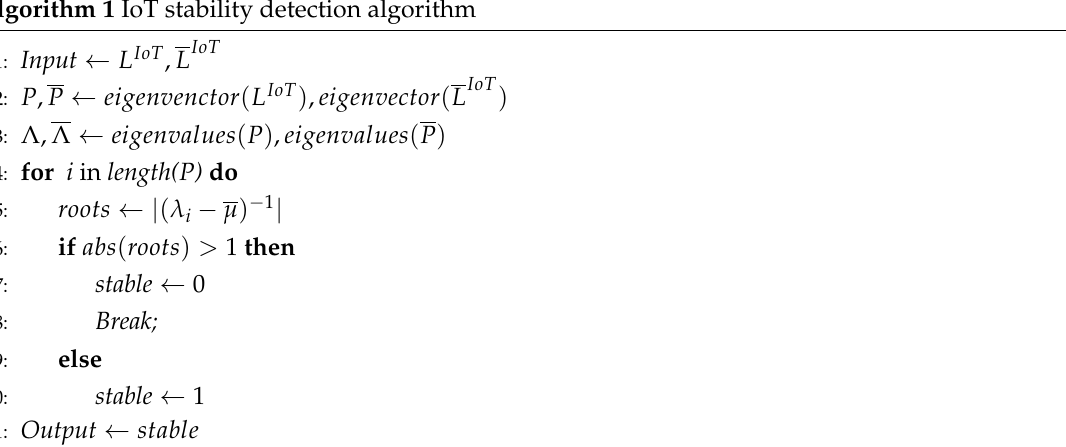
Algorithm 1 IoT stability detection